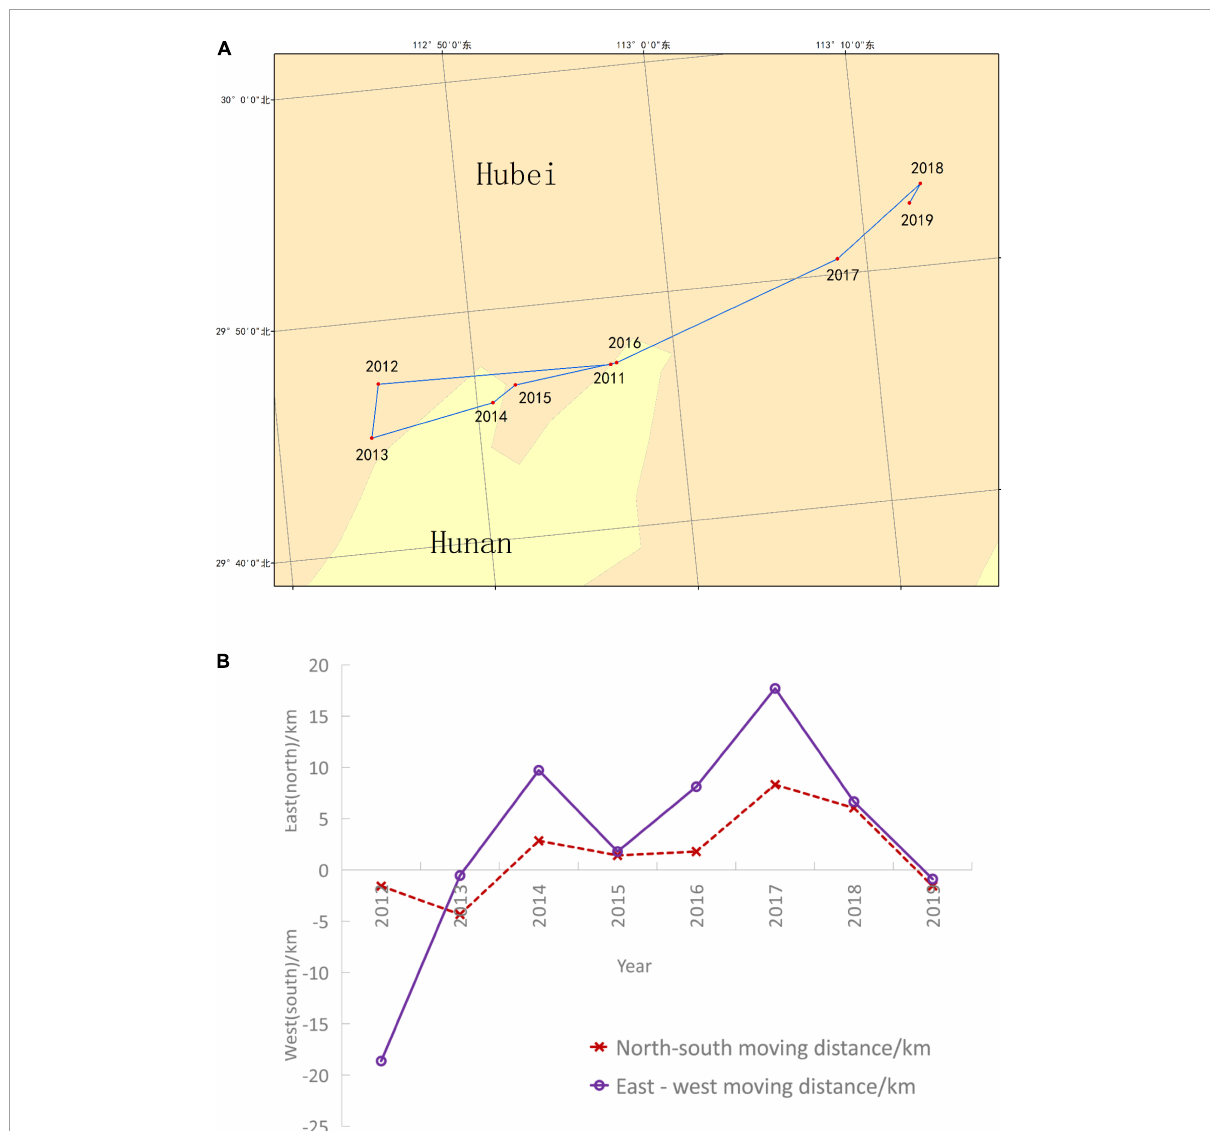
FIGURE3 Transfer of the center of gravity of input–output efficiency of WEF nexus. (A) Transfer track of the center of gravity from 2011 to 2019. (B) Transfer distance of the center of gravity from 2011 to